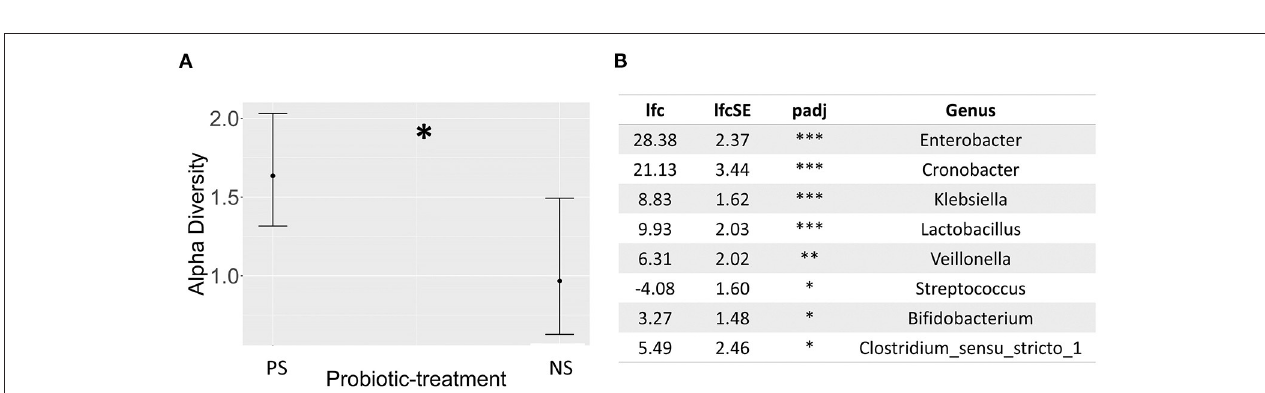
FIGURE 1 | (A) Significance and the amount of variance in gut microbiome composition explained by several microbiome covariates modeled with EnvFit on an NMDS ordination based on Bray-Curtis distances from the 16S rRNA short amplicon sequencing data. The x axis describes the explained variance (r 2 ) and the color the p -value (adjusted for false discovery rate with the Benjamani-Hochberg method). Annotation for necrotising enterocolitis, NEC; retinopathy of prematurity, ROP. P < 0.05 = *. (B) Principle coordinate analysis (PCoA) plot based on ASV level taxonomy obtained through 16S rRNA short amplicons sequencing describing the dissimilarity of probiotic-supplemented ( n = 63) and non-supplemented groups ( n = 31) based on taxonomy.